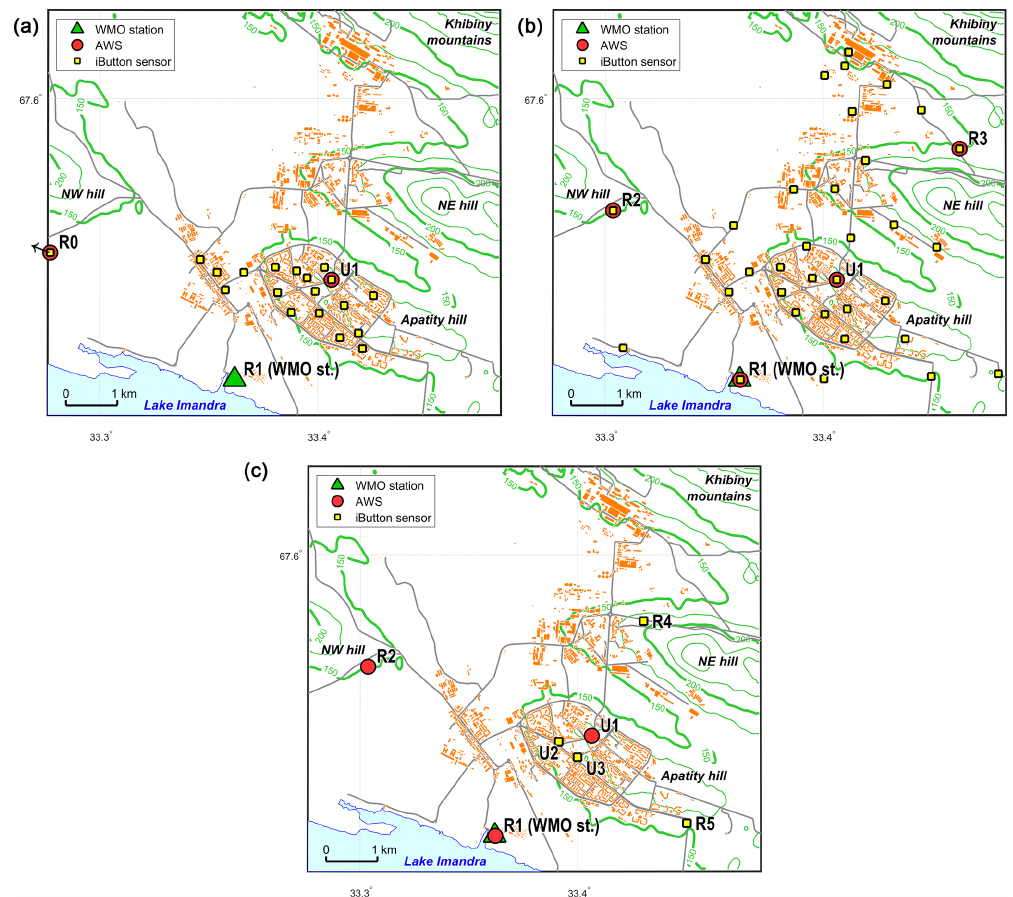
Figure 2. Maps of the observation sites from the (a) 2014, (b) 2015 and (c) 2015/16 field campaigns. The details of the location and a description of individual sensors are given in Table S1 in the Supplement. Elevation is shown using green contour lines, which are indicated every 25m, with the 150 and 200m contour lines displayed in